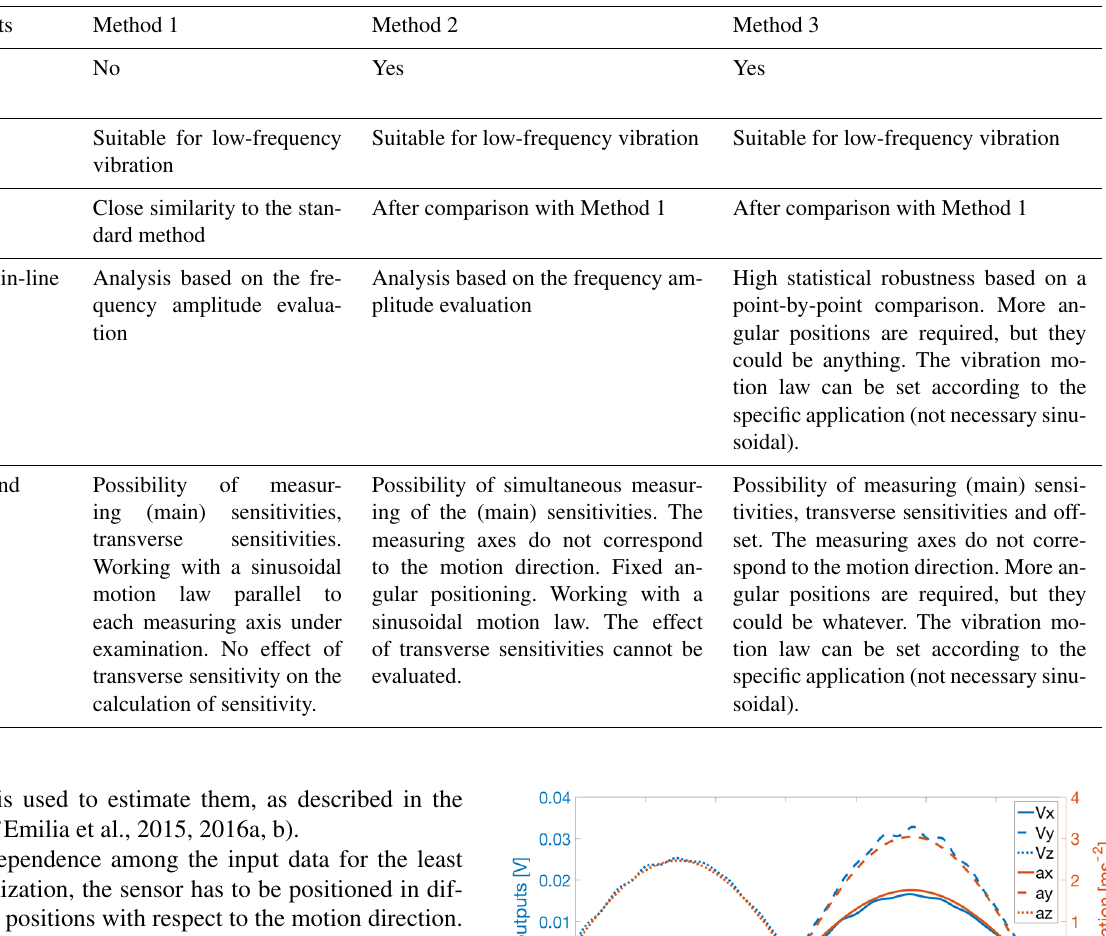
Table 1. Pros and cons of the methods with respect to requirements.